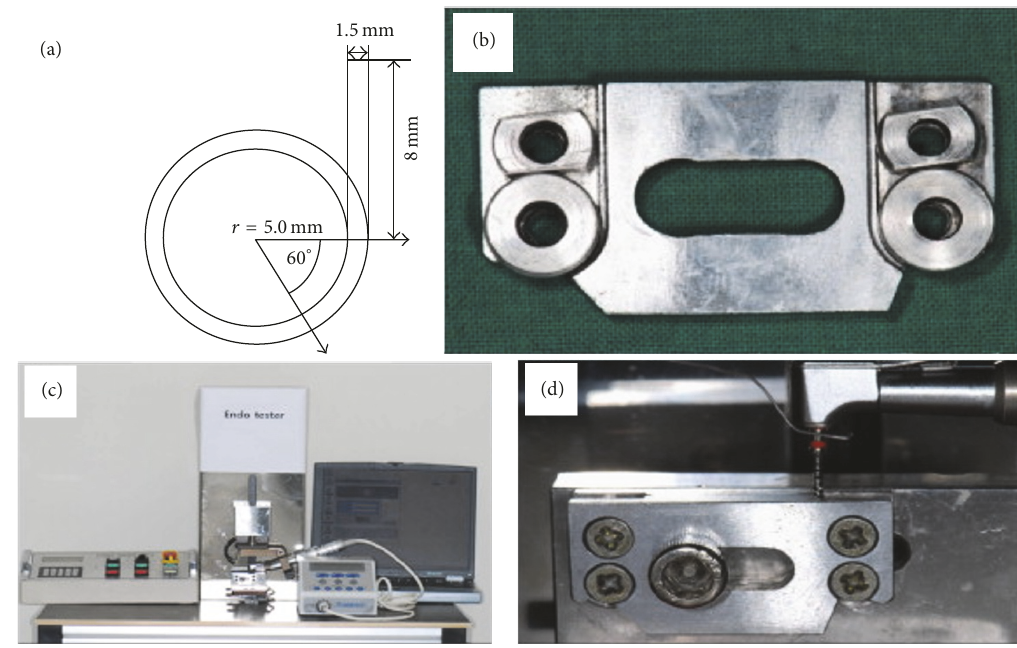
Figure 1: Cyclic fatigue resistance measuring equipment and diagram of an artificial canal. (a) Schematic diagram of artificial canal. (b) Metal blocks constituting artificial canal. (c) Setup of cyclic fatigue resistance measuring equipment. (d) Working NiTi instrument inside the artificial canal during experiment.